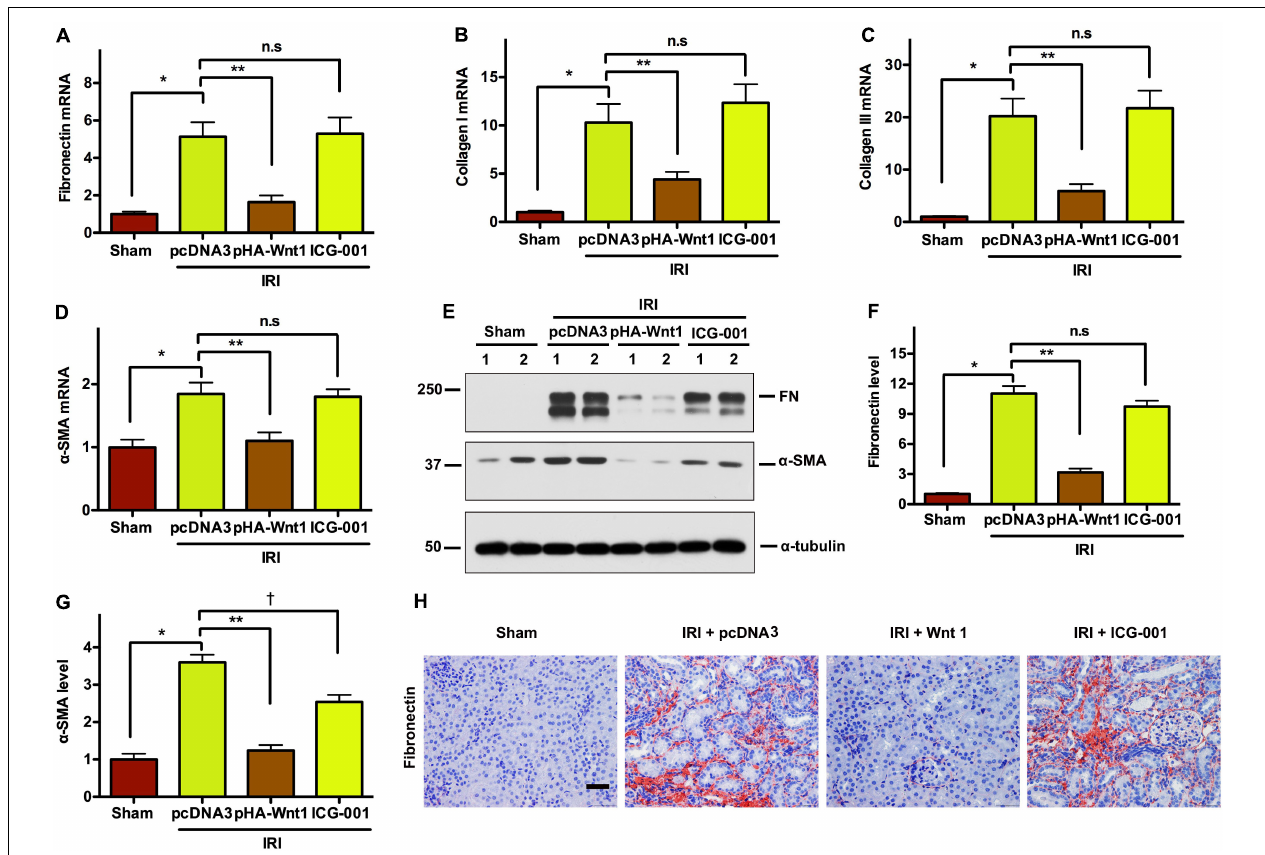
FIGURE 6 | In vivo expression of exogenous Wnt1 before IR reduces renal fibrosis in mice after AKI-CKD progression. (A–D) mRNA expression of fibronectin, collagen I, collagen III, and α -SMA. (E–G) Representative Western blot analyses of fibronectin and α -SMA-SMA protein levels. (H) Immunostaining of fibronectin in kidney sections. * P < 0.05; ** P < 0.01; † P < 0.05. n = 5. Scale bar, 50